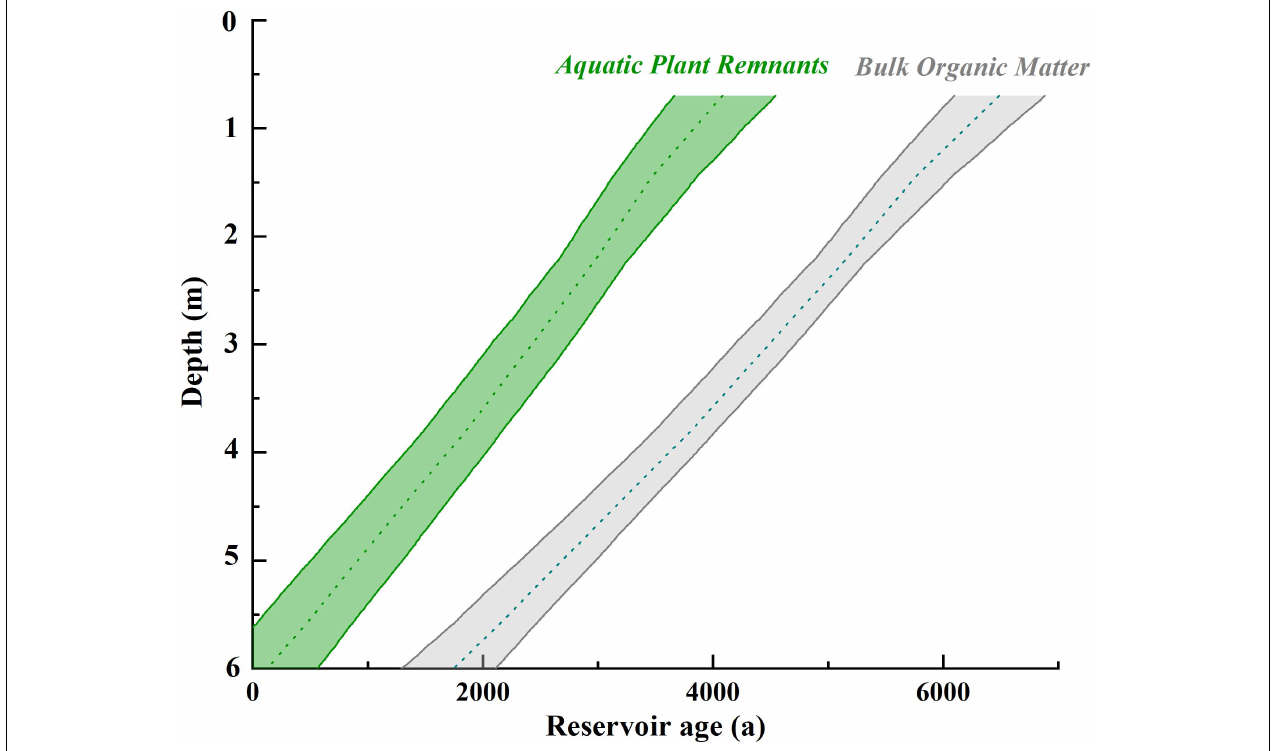
FIGURE 6 | The two shaded areas are the RAs-depth models. The green shaded area is the RAs-depth model for aquatic plant remnants, the gray shaded area is the RAs-depth of bulk organic matter. The two dotted lines represent the RAs median values.